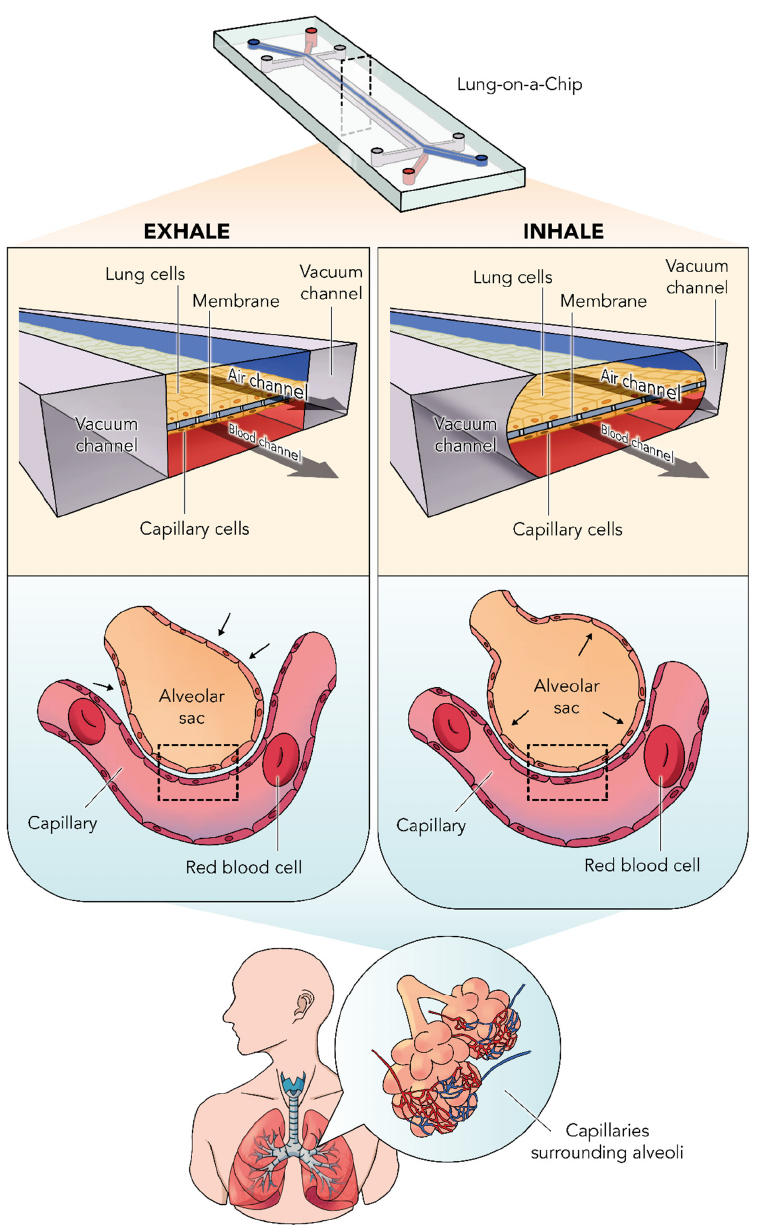
Figure 2. The mechanistic representation of the lung-on-a-chip (emulate chip) model. The principle of biological breathing (inhale–exhale) is reconstructed by applying vacuum to the channels on the sides. During the inhalation phase, this vacuum would cause a stretch on the membrane that represents the alveoli–capillary junction. The dotted line signifies the area where the membrane is stretched. Several drugs were reported to be screened using this technique [80].